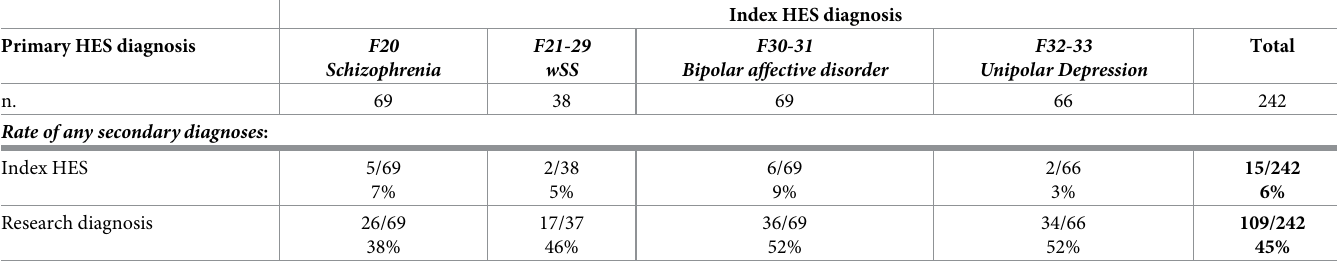
Table 3. Rate of secondary diagnoses recorded in HES and found in research diagnosis.